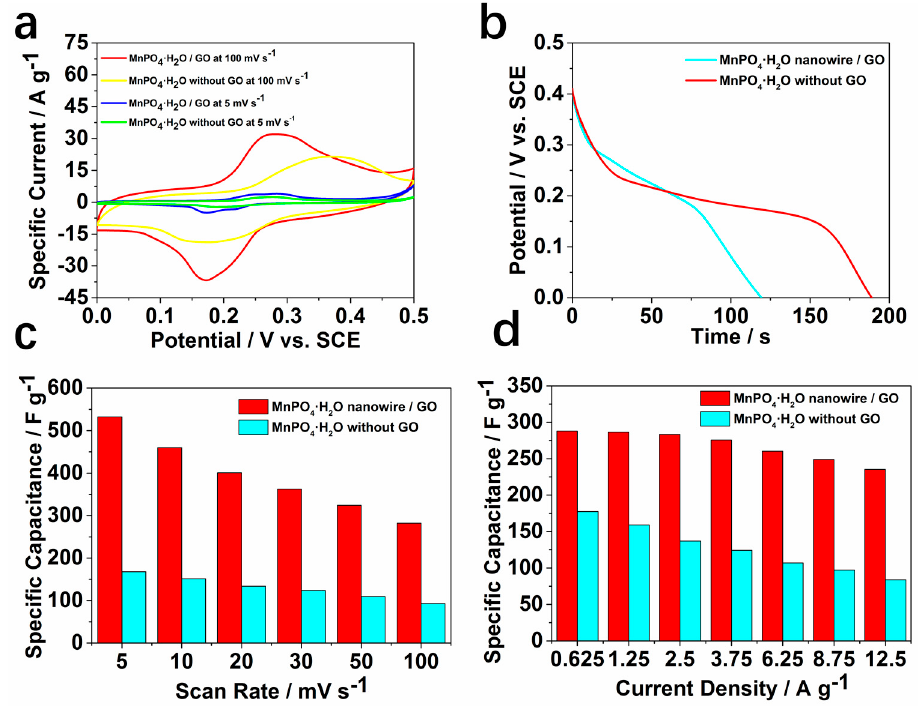
Figure 8. ( a ) CV curves of MnPO 4 · H 2 O nanowire/GO and MnPO 4 · H 2 O without GO at 5 mV · s − 1 and 100 mV · s − 1 in the three-electrode system; ( b ) the discharge times of the two samples at 0.625 A · g − 1 ; ( c ) specific capacitances of the two samples derived from the CV measurement; ( d ) specific capacitances of the two samples calculated from the GCD curves.